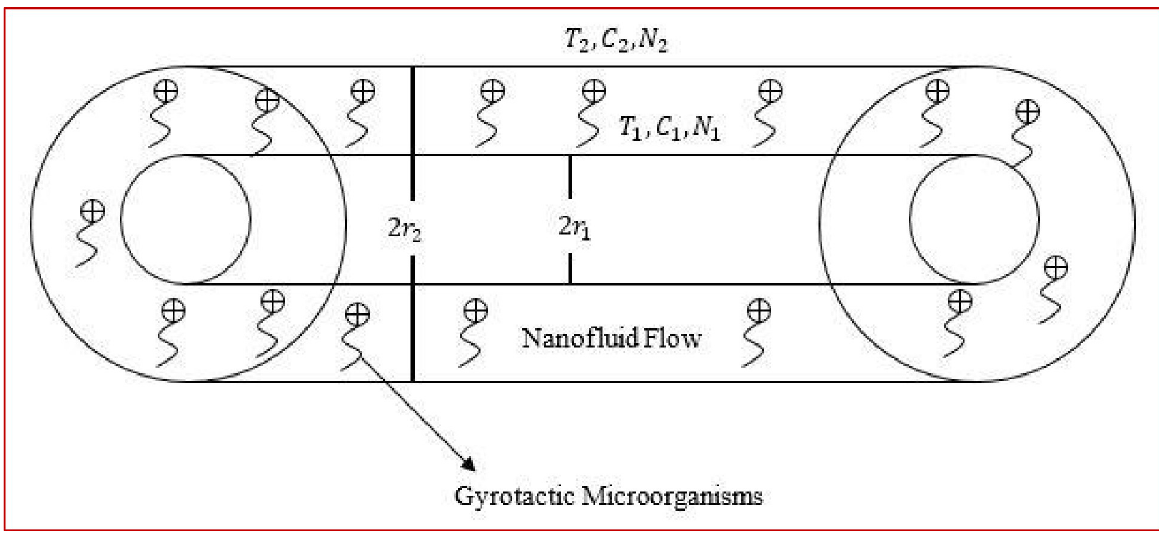
Fig 1. Schematic flow